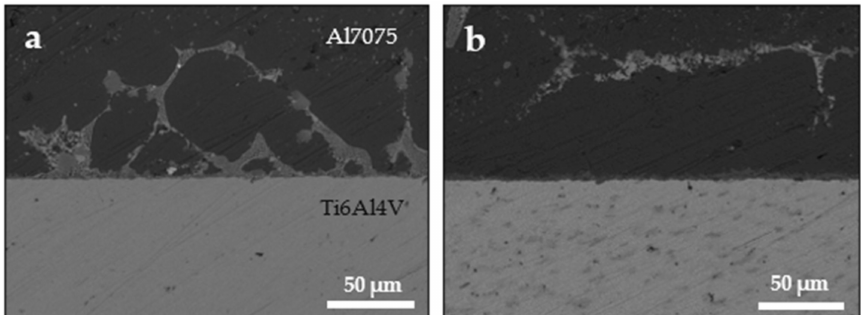
Figure 2. FE-SEM images of the Al7075/Ti-6Al-4V interface with Cu interlayer at 520 ◦ C and holding pressure of ( a ) 5 MPa and ( b ) 10 MPa, with a holding time of 10 min for both samples.